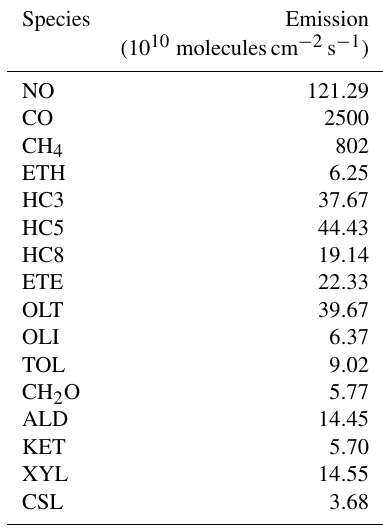
Table 2. VOC emissions in the FLUX test case.